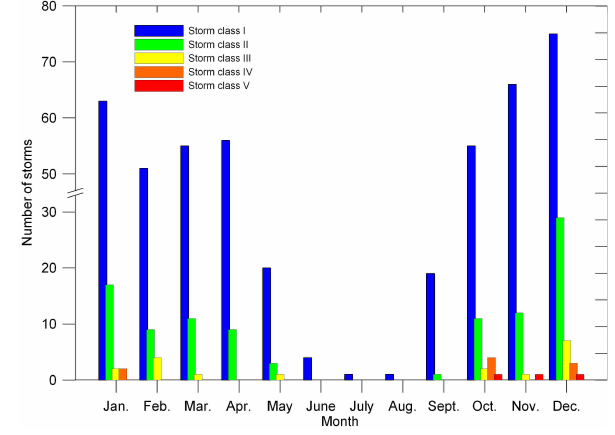
Fig. 7. Seasonal distribution of storms in the Catalan coast during the period